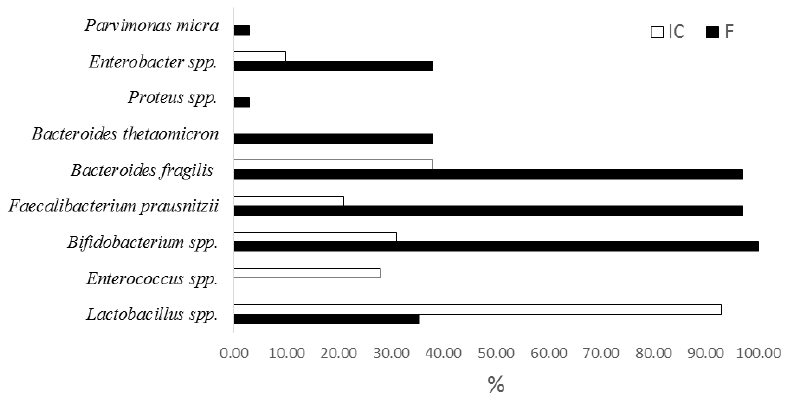
Figure 1. Frequency of different taxa identification in the composition of fecal samples and the indigenous consortium by qPCR study. Notes: Lactobacillus spp. > 5 lg CFU/g; Enetrococcus > 5 lg CFU/g; F—fecal samples; IC—indigenous consortium. Only statistically reliable results are presented. p < 0.05 were determined by χ2 test with Yates correction.